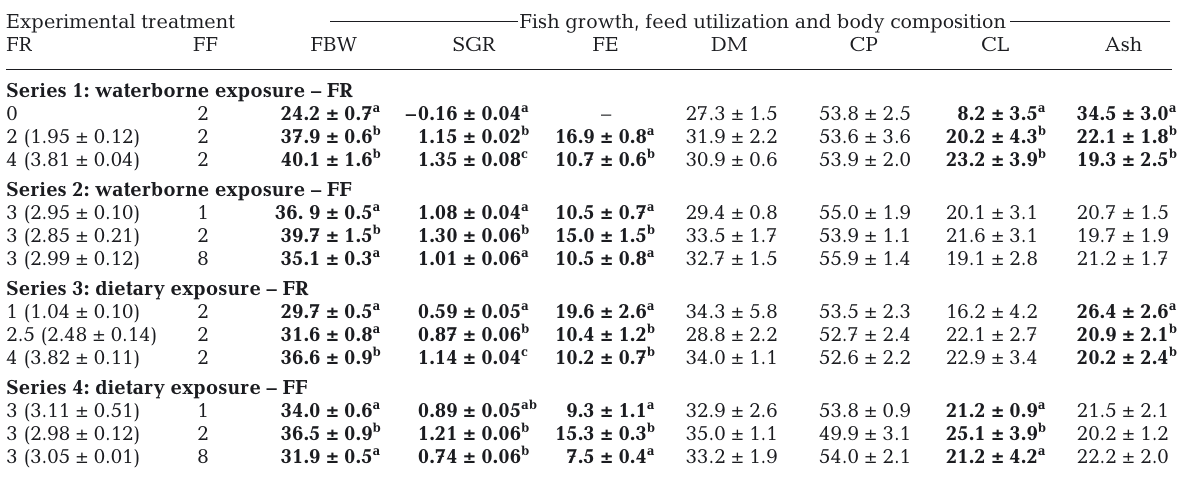
Table 2. Experimental treatments and effects of feeding ratio (% body weight d −1 , BW d −1 ) and feeding frequency (times d −1 ) on growth performance, feed utilization and body composition of black sea bream Acanthopagrus schlegeli exposed to water- borne (97.2 µg l −1 ) or dietary cadmium (254.4 µg g −1 ) for 5 wk. Values are means ± SD; means in bold with different super- scripts were significantly different between the treatments (p < 0.05); means in normal print were not significantly different. FR (%BW d −1 ): feeding ratio (measured values in brackets); FF (times d −1 ): feeding frequency; FBW (g fish −1 ): final body weight; SGR (% d −1 ): specific growth rate; FE (%): feed efficiency; DM (%): dry matter; CP (%, in dry matter): crude protein; CL (%, in dry matter): crude lipid. Values are means of replicated groups in FBW, SGR, and FE. Values are means of